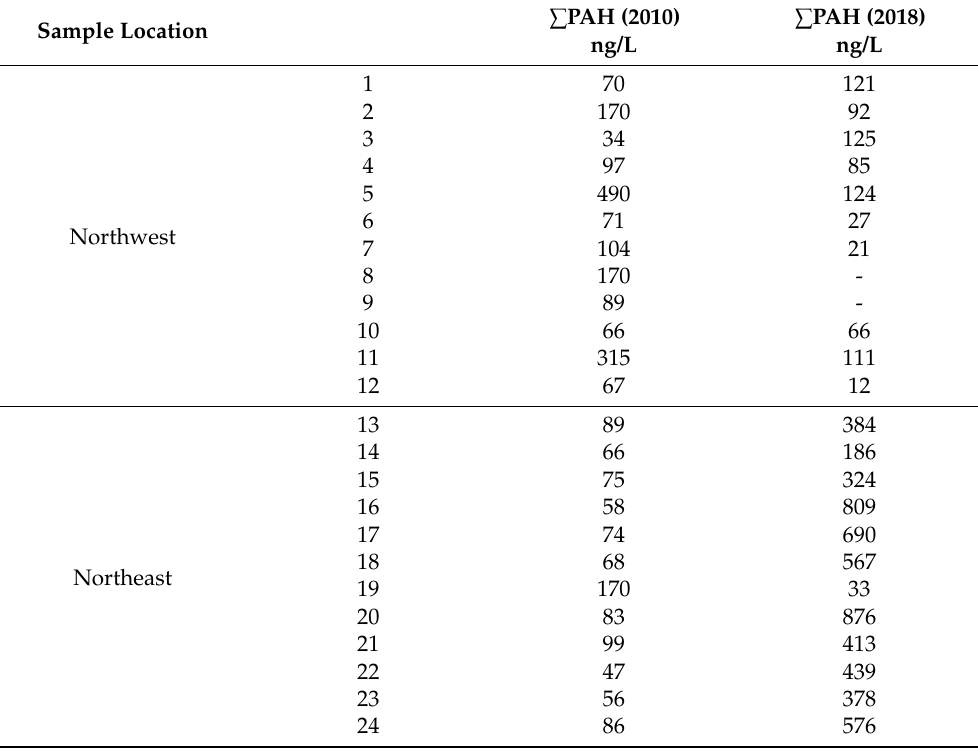
Table 1. Sum of porewater PAHs averaged over depth in 2010 and 2018.